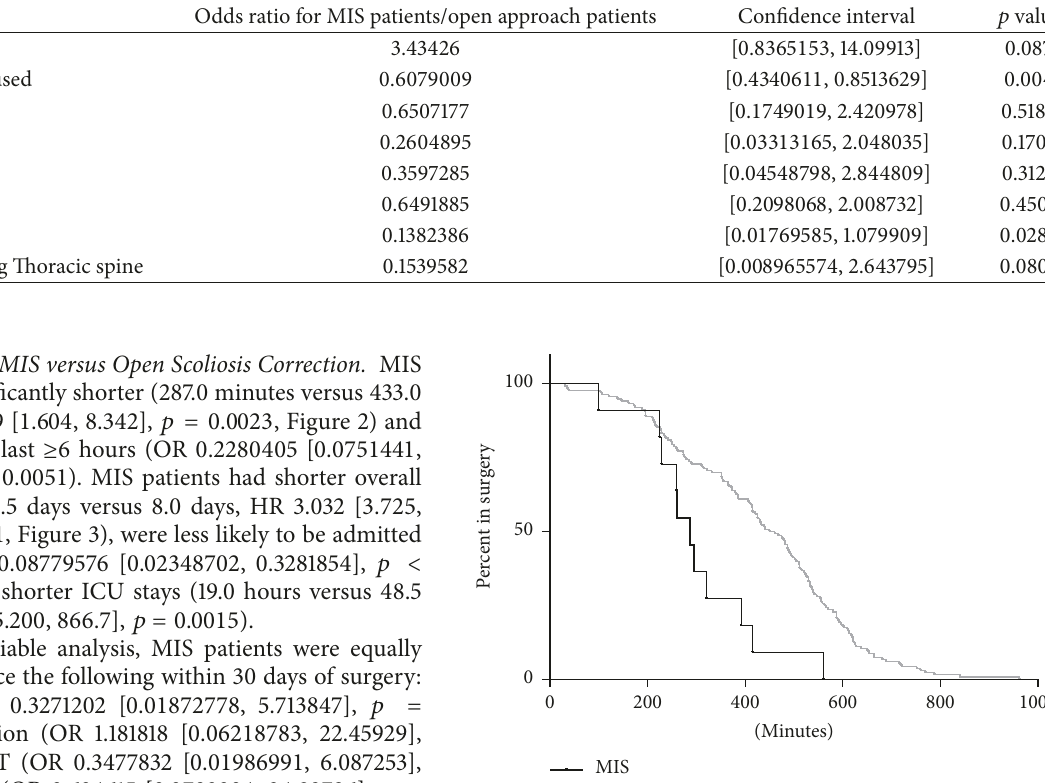
Table 3: Surgical procedure data for MIS approach versus open approach. Odds ratio for MIS patients/open approach patients